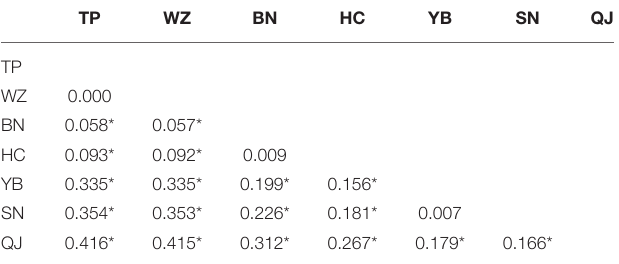
TABLE 3 | Genetic differentiation ( Fst ) among seven populations of S. dabryi in the upper Yangtze